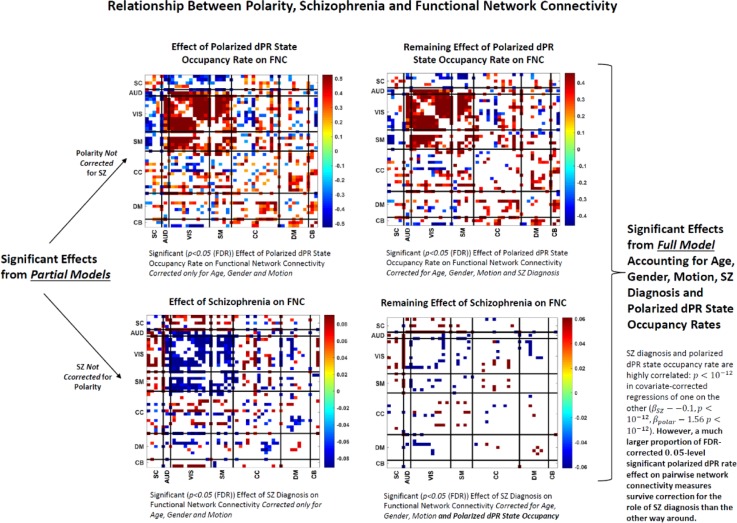
(Top Left) Significant (p<0.05 (FDR)) effects of polarized dPR occupancy on functional network connectivity in multiple regression that accounts for age, gender and motion but not for schizophrenia diagnosis; many strong positive effects within and between auditory (AUD), visual (VIS) and sensorimotor (SM) networks combined with some strong negative effects between subcortical (SC) and cerebellar (CB) networks and the auditory-visual-sensorimotor (AVSM) block; (Top Right) Significant (p<0.05 (FDR)) effects of polarized dPR occupancy on functional network connectivity in multiple regression that accounts for age, gender and motion and also schizophrenia diagnosis; many effects from the partial model to the left survive; broad effect patterns similar after correcting for the role of schizophrenia diagnosis; (Bottom Left) Significant (p<0.05 (FDR)) effects of schizophrenia on functional network connectivity in multiple regression that accounts for age, gender and motion but not for polarized dPR state occupancy rates; many strong negative effects in the AVSM block networks combined with strong positive effects between subcortical and cerebellar networks and the AVSM block (Bottom Right) Significant (p<0.05 (FDR)) effects of schizophrenia on functional network connectivity in multiple regression that accounts for age, gender and motion and also polarized dPR state occupancy; a small proportion of effects from the partial model to the left survive after correcting for the role of dPR state occupancy.